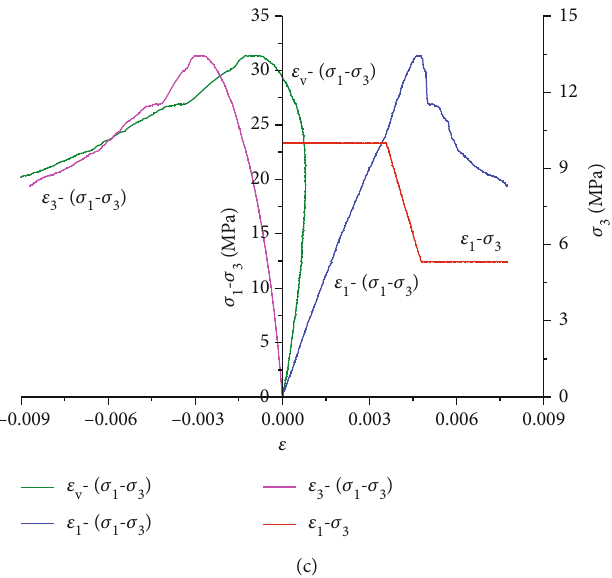
Figure 4: Unloading test of coal samples with di ff erent Table 2: Test results of unloading and triaxial compression failure.